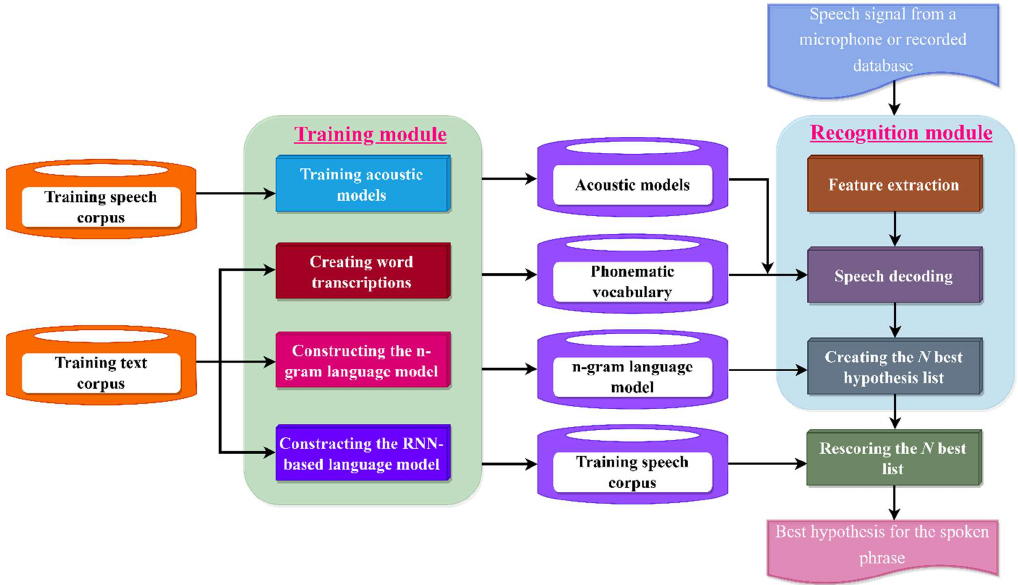
Figure 8. Architecture of RNN- and LM-based recognition system for continuous Uzbek speech.